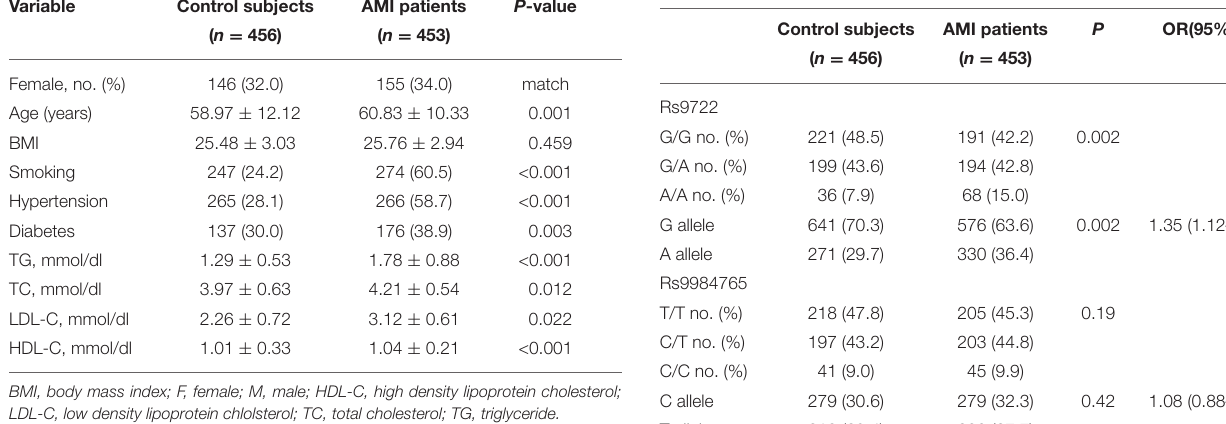
TABLE 2 | Clinical characteristics of AMI patients and control subjects. Variable